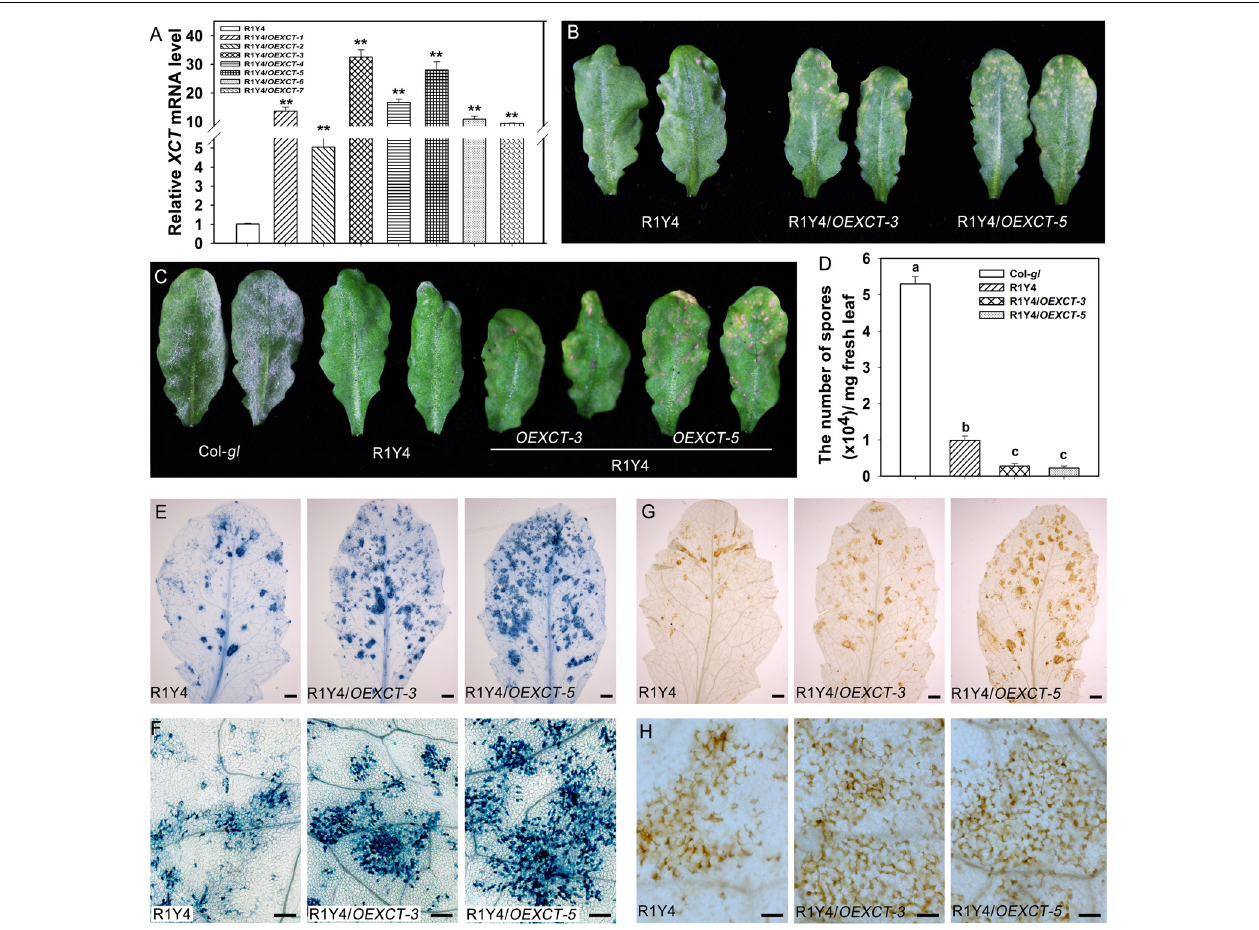
FIGURE 6 | Overexpressing XCT enhances RPW8.1 –mediated cell death and disease resistance. (A) Relative mRNA levels of XCT detected by quantitative RT-PCR (qRT-PCR) in the indicated transgene lines. Error bars indicate SD ( n = 3). Asterisks ∗∗ above the bars indicate significant differences ( P < 0.01) as determined by Student’s t- test between R1Y4 and the indicated transgenic lines (R1Y4/ XCTOE-1 ∼ R1Y4/ XCTOE-7 ). (B) Representative leaves from the indicated lines of 5-week-old plants show the difference of cell death lesions. (C) Representative leaves show the disease phenotype of powdery mildew. Photos were taken at 10 dpi. (D) Quantitative analysis of sporulation at 10 dpi of the indicated lines. Error bars represent SD ( n = 8). Letters above the bars indicate statistically significant differences at P < 0.01. (E–H) Representative leaves (E,G) and leaf sections (F,H) stained by trypan blue (E,F) and DAB (G,H) from R1Y4 and XCT -overexpressing lines at 10 dpi show clusters of cell death and H 2 O 2 accumulation, respectively. Scale bars: (E,G) 2 mm; (F,H) 50 µ